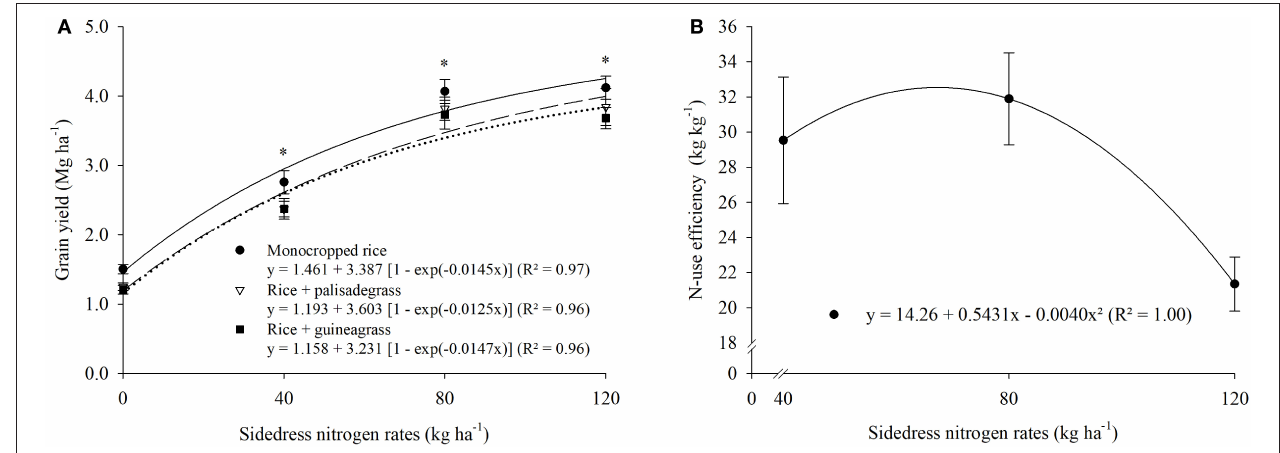
FIGURE 2 | Cropping system × sidedress nitrogen rates interaction effect on grain yield of upland rice (A) , and N-use efficiency as affected by sidedress nitrogen rate (B) . Each data point is the mean of 36 replicates (three cropping systems, four blocks, and three growing seasons) and associated error bar is ± one SE. * P ≤ 0.05.